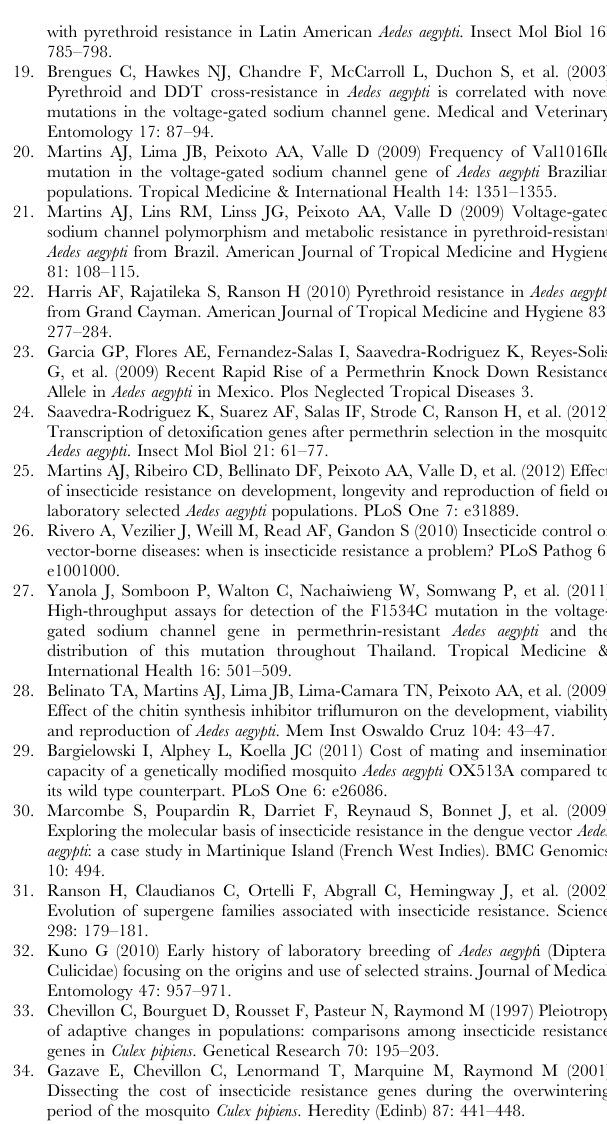
Figure S1 Adult longevity of Rock-kdr and Rock Ae. aegypti strains. Survival curves of males (A) and females (B, C) fed exclusively with sugar solution (A, B) or with sugar and two blood meals (offered at days 2 and 11). Figure S2 Blood feeding. Each dot represents a pool of females weight before and after blood feeding. Median and SE were evidenced. Table S1 Competition analysis, development time until adult. Number of daily emerged males.